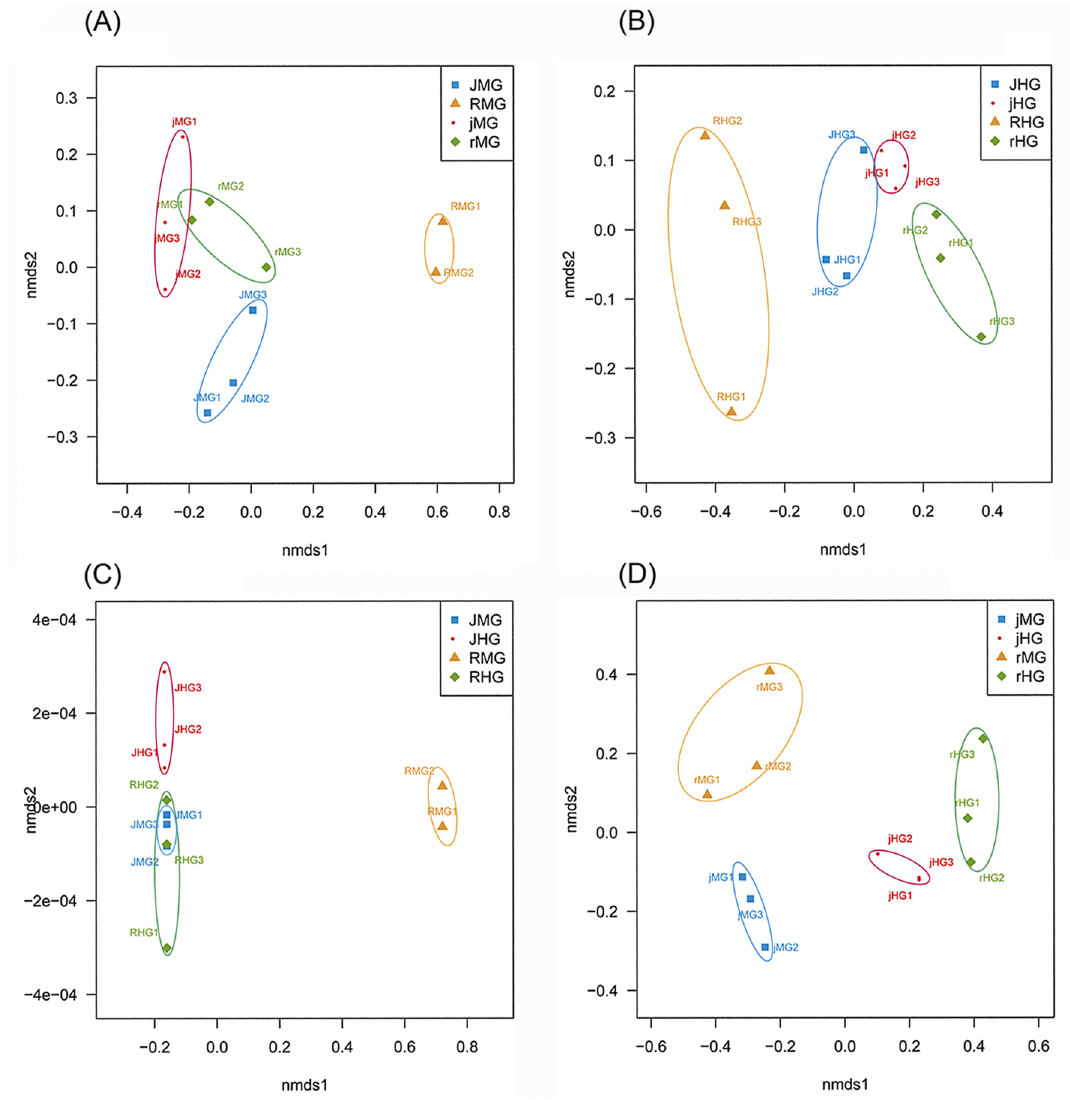
Figure 7. NMDS of the gut microbiota of C. suppressalis . ( A ) NMDS of the taxon distribution of midgut samples. The samples were clustered by diets and represented with different colors: jMG (red, circles), rMG (green, rhombus), JMG (blue, squares) and RMG (saffron yellow, triangle). ( B ) NMDS of the taxon distribution of the hindgut samples. The samples were clustered by diets and represented with different colors: jHG (red, circles), rHG (green, rhombus), JHG (blue, squares) and RHG (saffron yellow, triangle). ( C ) NMDS of the taxon distribution of the midgut and hindgut samples from the water-oat and rice populations. The samples were clustered by diets and represented with different colors: JHG (red, circles), RHG (green, rhombus), JMG (blue, squares) and RMG (saffron yellow, triangle). ( D ) NMDS of the taxon distribution of the midgut and hindgut samples from cross-rearing populations. The samples were clustered by diets and represented with different colors: jHG (red, circles), rHG (green, rhombus), jMG (blue, squares) and rMG (saffron yellow, triangle). The ellipses represent the standard error of the centroid for each group of samples with a confident limit of